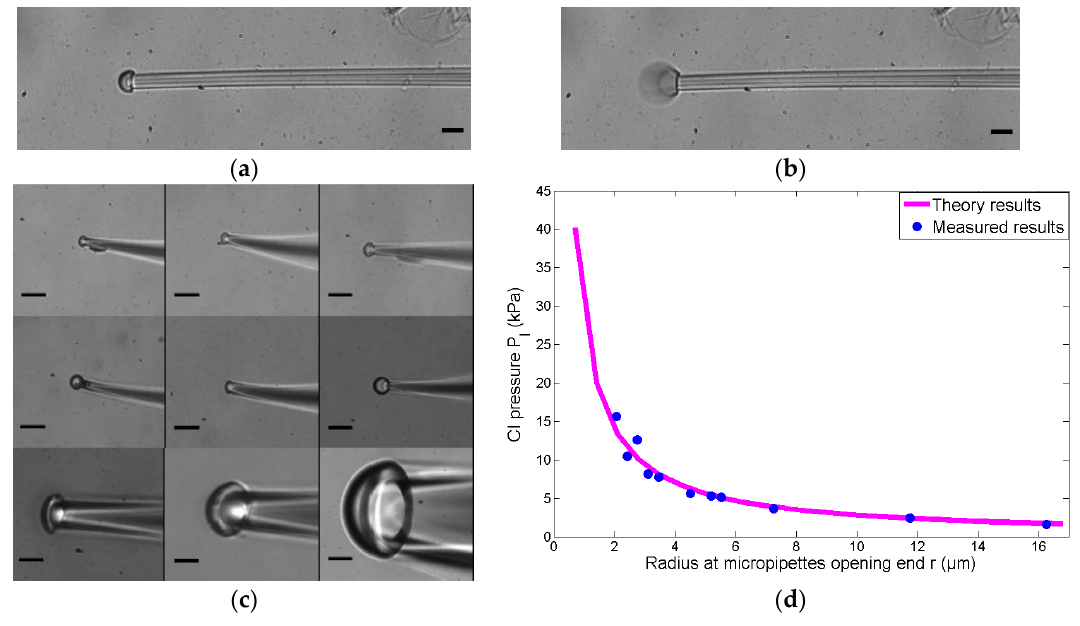
Figure 5. The critical injection experiments. ( a ) The state at t n − 1 , the moment before the certain moment t n − 1 , is defined as the CI state. ( b ) The liquid will be injected out at a certain moment t n . ( c ) The micropipettes in the CI state in the critical injection experiments; the scale bar is 10 μ m; ( d ) the results of the CI experiments. The theoretical CI pressures (the pink curve), according to Equation (3), are compared with the measured ones (the blue points). Parameters: σ = 16.56 N/m, cos α ≈ 1, β = 30°, ρ = 998.2 kg/m 3 . Table 1. The measured critical injection (CI) pressure versus r , and the theoretical CI pressure versus r , according to Equation (3).